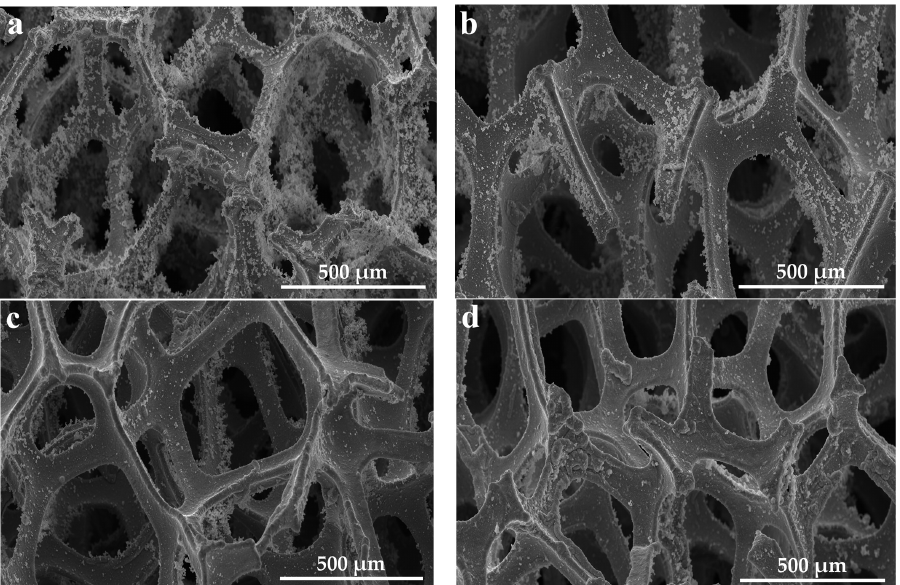
Figure 4. SEM images of the samples: ( a ) Ni(OH) 2 -pure; ( b ) Ni(OH) 2 -PVP; ( c ) Ni(OH) 2 -PVP-Co- elchem; ( d ) Ni(OH) 2 -PVP-Co-chem.